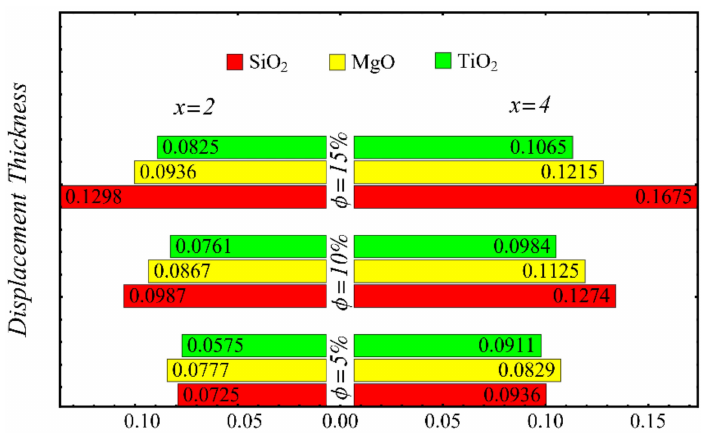
Figure 21. Displacement thickness at different nanoparticle